Question: Produce a descriptive caption suitable for publication.
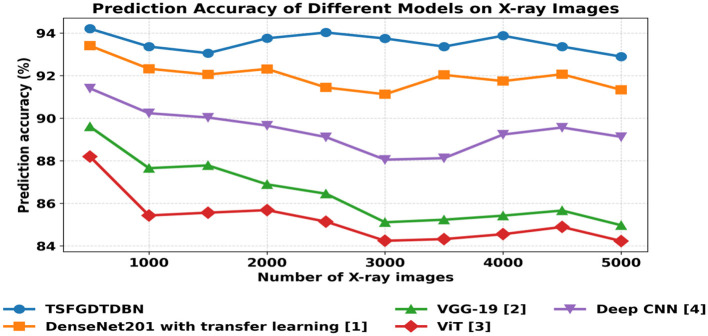
Answer: Performance analysis of prediction accuracy using Multi-Class Knee Osteoporosis X-ray Dataset.